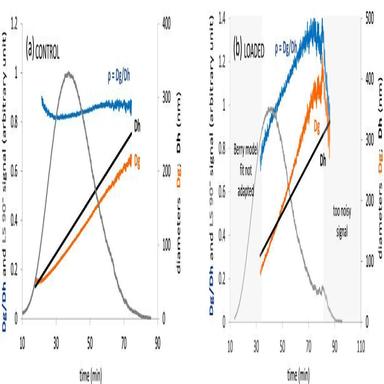
AF4-MALS fractogram obtained at angle 90◦ in isocratic elution mode for (a) control NPs and (b) loaded NPs. The calculated gyration diameter Dg (in orange), hydrodynamic diameter Dh (in black) and the ratio Dg/Dh (in blue) are also presented. (For interpretation of the references to colour in this figure legend, the reader is referred to the web version of this article.)